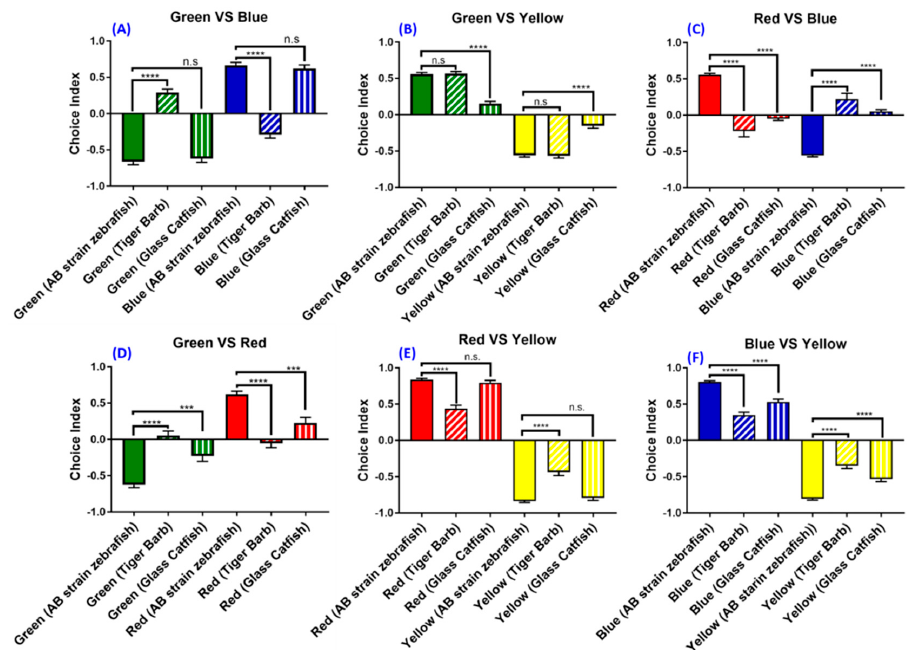
Figure 7. Color preference ranking and index di ff erence for the tiger barb ( Puntigrus tetrazona ) and glass catfish ( Kryptopterus vitreolus ). The color preference index for the ( A ) green vs. blue, ( B ) green vs. yellow, ( C ) red vs. blue, ( D ) green vs. red, ( E ) red vs. yellow, ( F ) and blue vs. yellow combinations. The data are presented as mean ± SEM, n = 24 for each fish species. The di ff erence was tested by one-way ANOVA and the significance level was set at *** p < 0.001, **** p < 0.0001. n.s. =